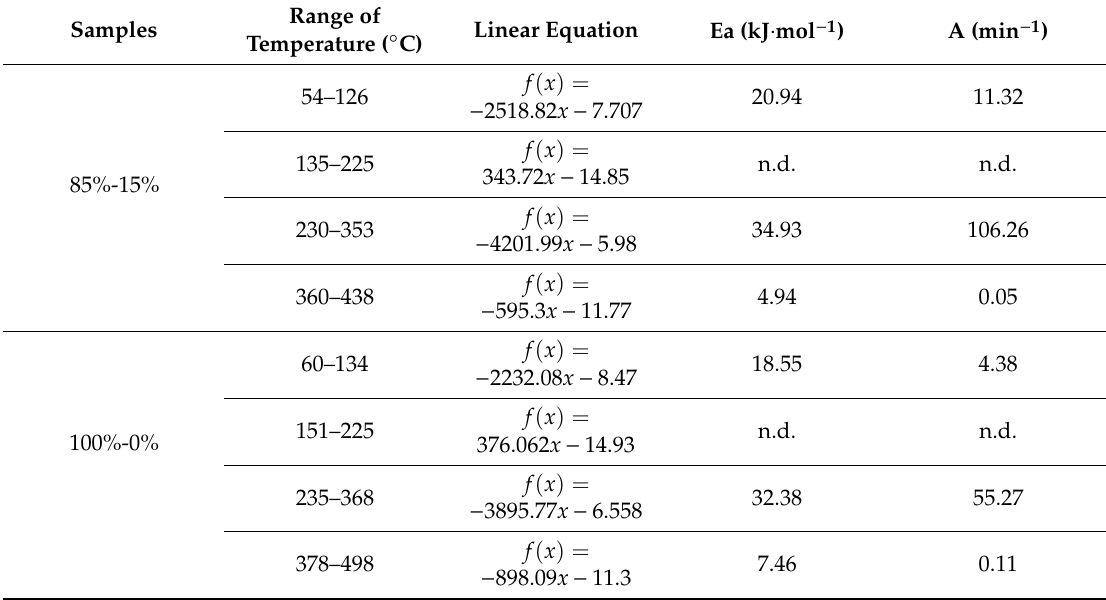
Table 5. Kinetic parameters determination during the nonisothermal